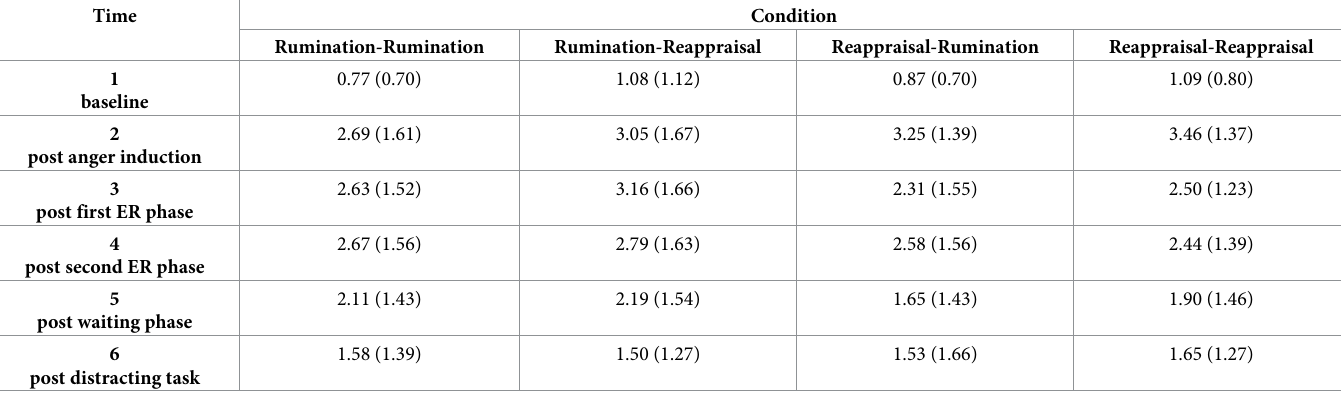
Table 1. Means of self-reported anger about the angering event for each condition, with standard deviations in parentheses. Time Condition Rumination-Rumination Rumination-Reappraisal Reappraisal-Rumination